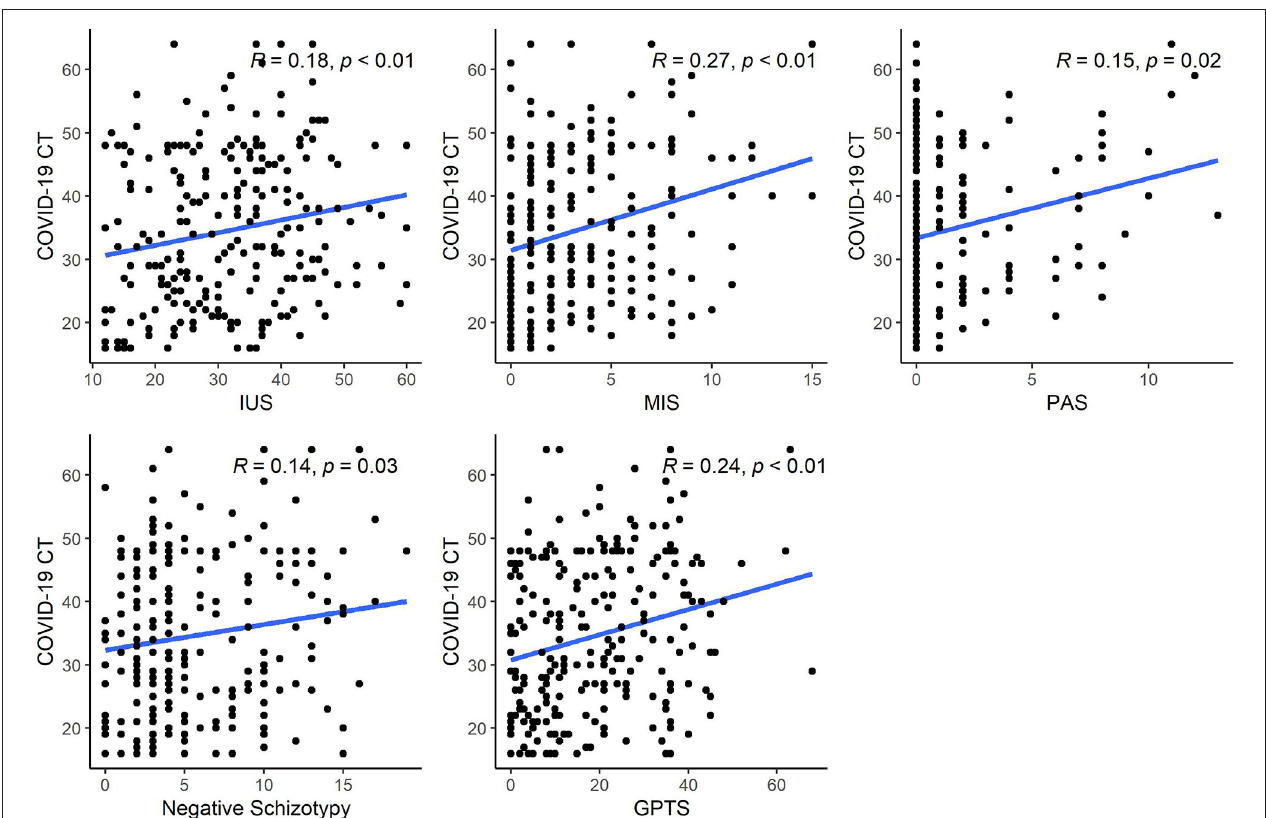
FIGURE 1 | Correlation coefficients for MIS and PAS represent Spearman’s Rho while all others represent Pearson’s R. CT, Conspiratorial thinking; IUS, Intolerance of Uncertainty Scale; MIS, Magical Ideation Scale; PAS, Perceptual Aberration Scale; GPTS, Green et al. Paranoid Thought Scale.